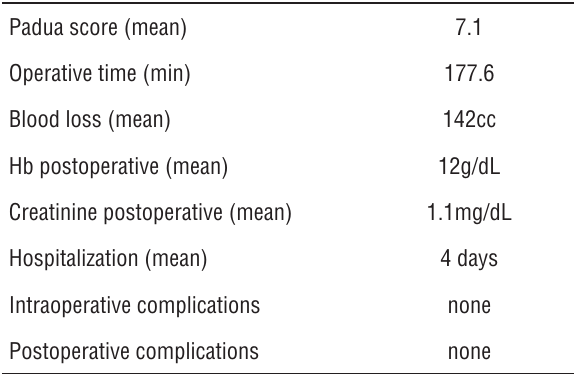
Table 2 - Perioperative